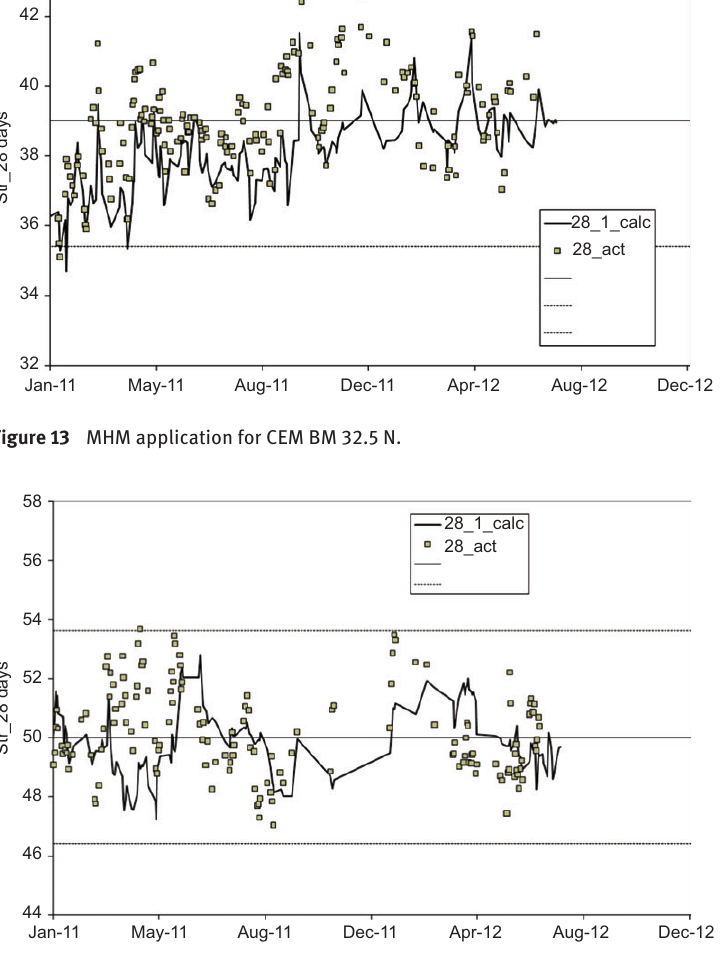
Figure 14 MHM application for CEM AL 42.5